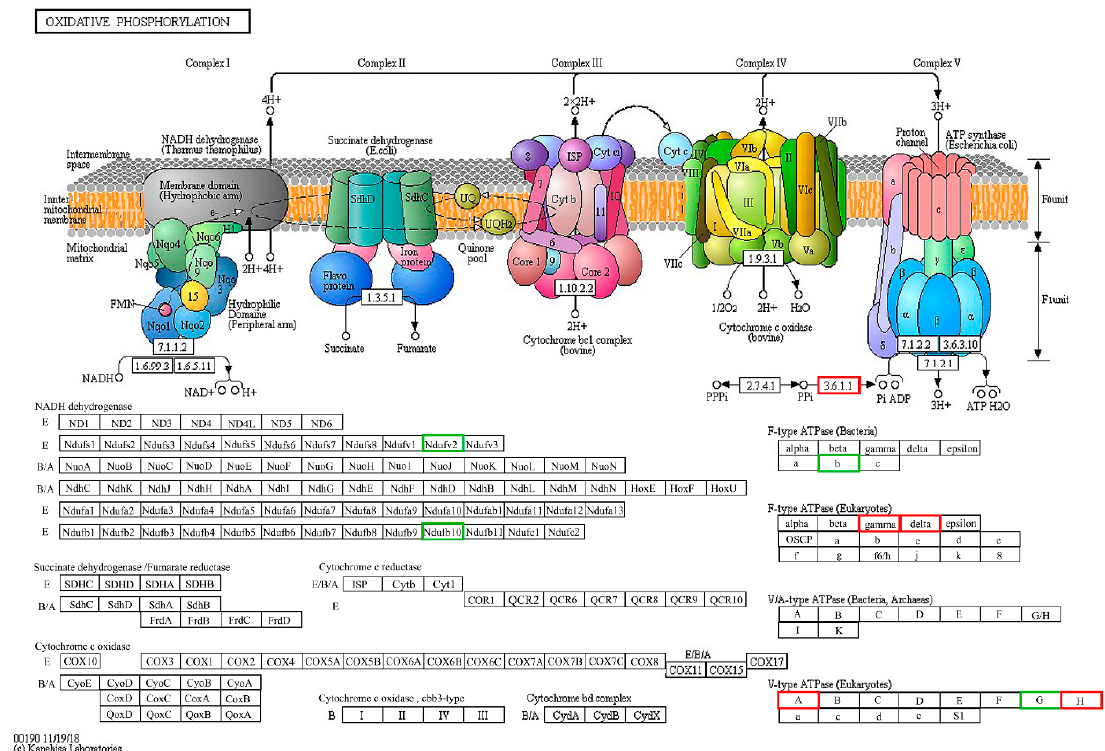
Figure 8. A KEGG map of the Oxidative phosphorylation pathway of DEPs in A13 + TMV versus CK + TMV. The boxes with red frames correspond to the up-regulation of DEPs in the A13 + TMV sample. The boxes with green frames correspond to the down-regulation of DEPs in the A13 + TMV sample.